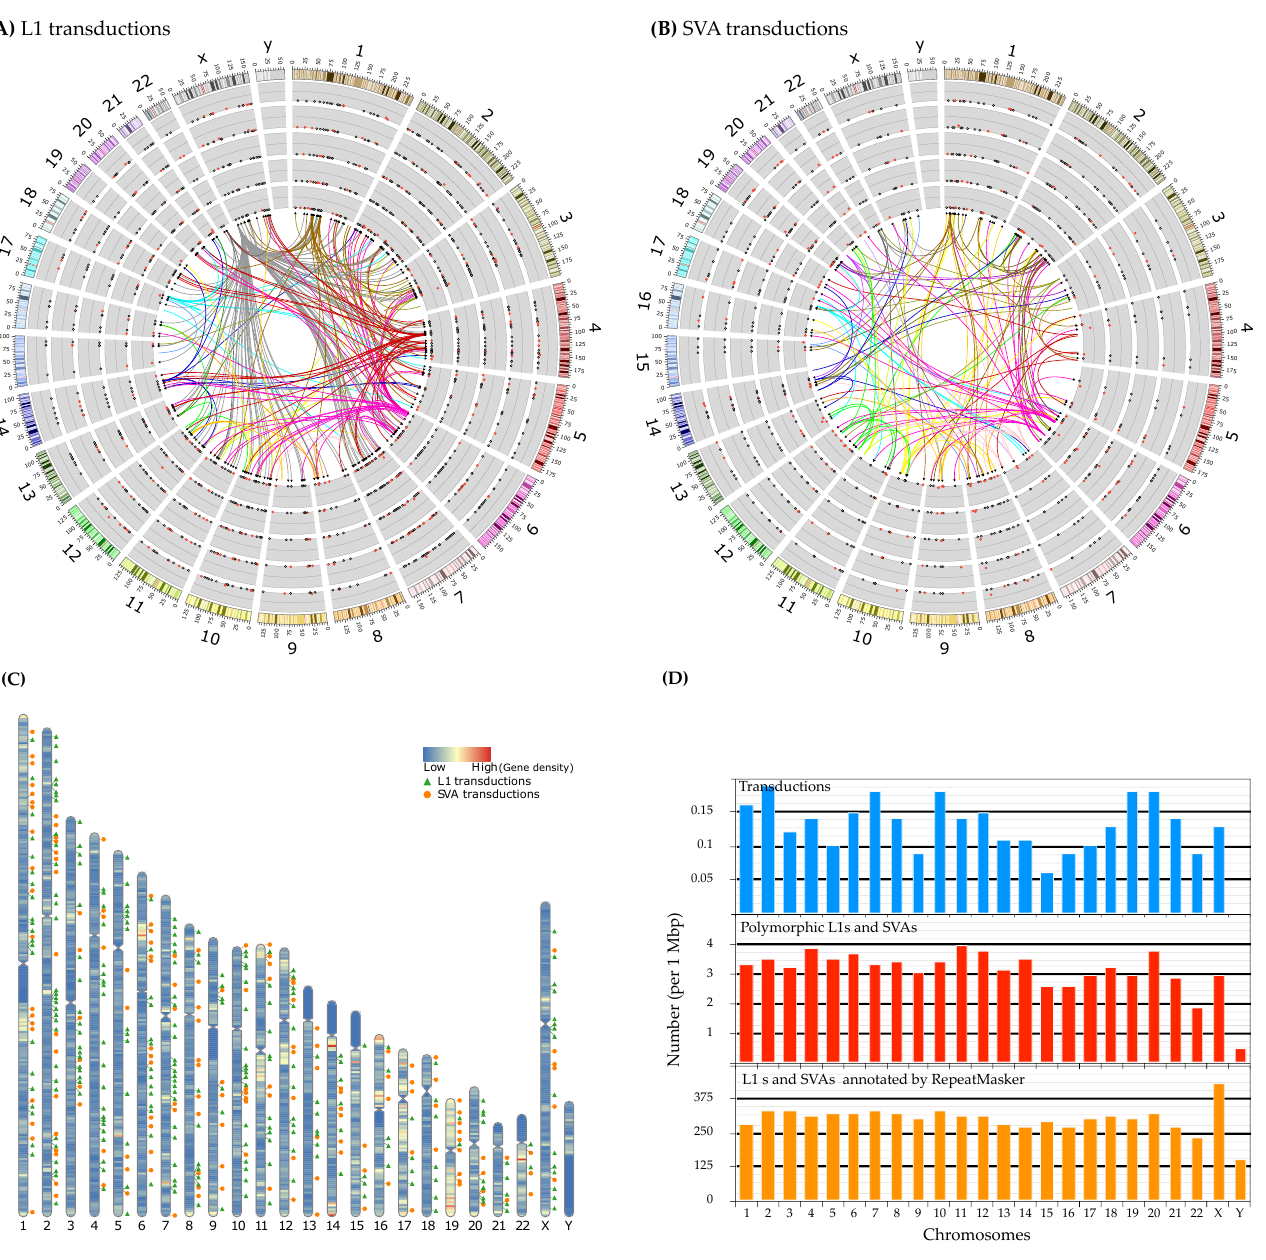
Figure 7. Connection(s) of progenitors and offspring, chromosomal distribution, and allele frequency of 3 (cid:48) transductions across the super-populations. ( A , B ) The circos plots with directed links depict the genome-wide relationship of each progenitor-offspring (links are color-coded based on the chromosomal location of the source loci). Alternate haplotypes present in GRCh38 are not shown in these plots. The scatter plots represent the allele frequency of each offspring locus per super- population (from inside AFR, AMR, EUR, SAS, and EAS, respectively). Black circles within the scatter plots indicate that the allele frequency for that locus is zero. In contrast, a red dot denotes a non-zero allele frequency for a transduction locus. Allele frequencies are plotted on a scale of 0 to 0.25. In these graphs, only high-confidence events are shown. In both plots, the ideograms are the human chromosomes (GRCh38) with their cytogenetic bands. ( C ) Location and distribution of transduction events along the chromosomes with gene density heat map. ( D ) Number (per 1 Mbp) of L1s and SVAs in the GRCh38, polymorphic loci, and transduction variants compared to each other. This plot illustrates that the number of identified polymorphic MEIs and transduction variants in this study is proportional to the genome-wide L1 and SVA